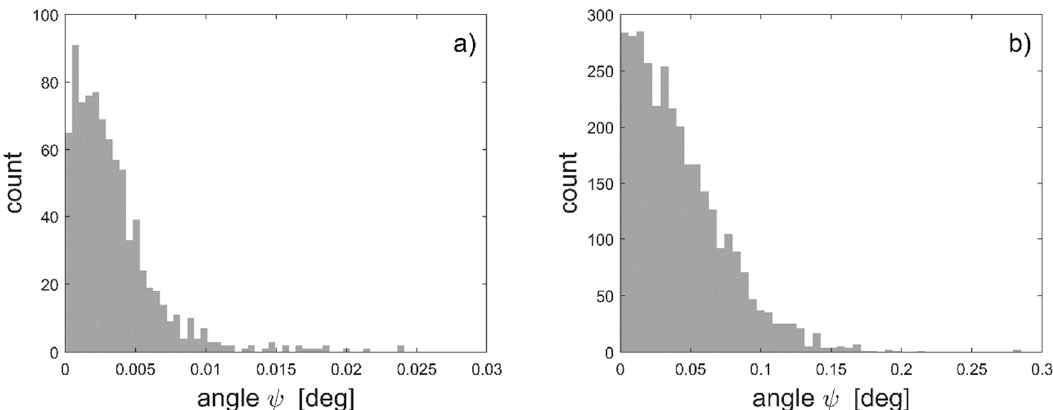
Figure 3. Histograms of angles ψ calculated from data obtained in Experiment 1 with: ( a ) laser tracker; ( b ) motion capture system.